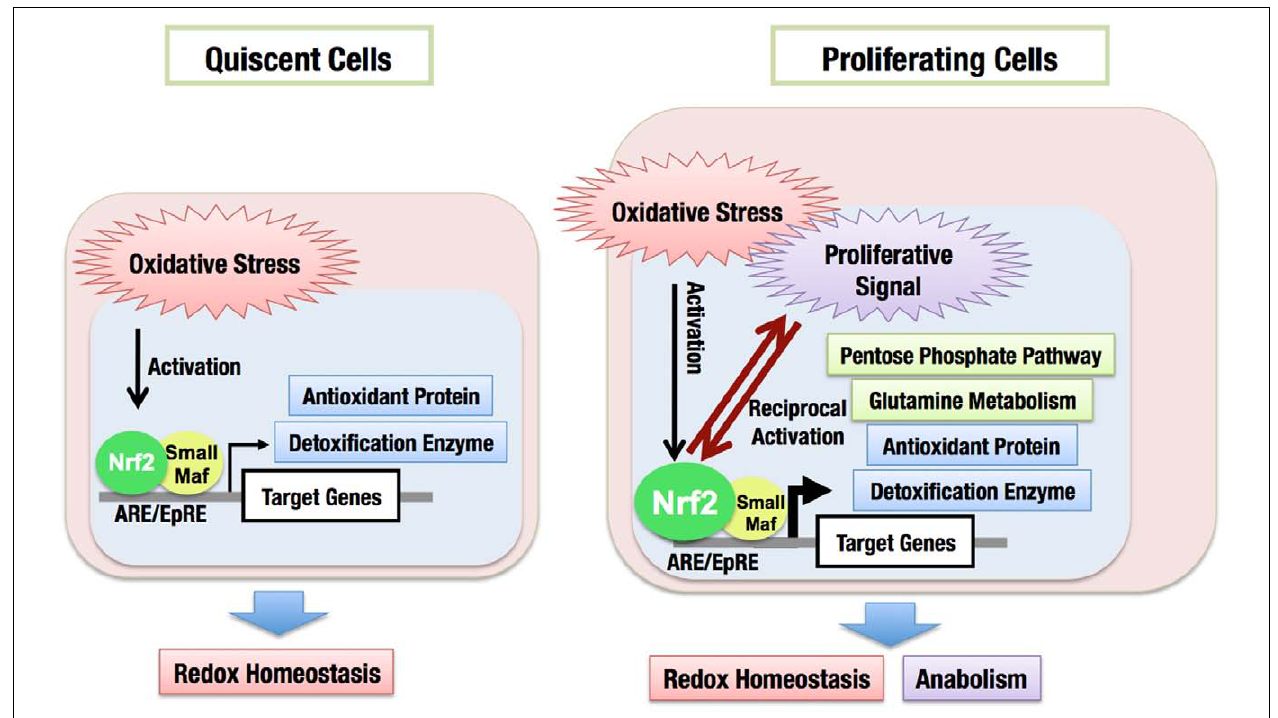
FIGURE 9 | Functional expansion of Nrf2 in proliferating cells. In quiescent cells, Nrf2 is activated in response to oxidative stress and induces the expression of cytoprotective genes encoding antioxidant proteins and detoxification enzymes, which maintains the cellular redox homeostasis. In